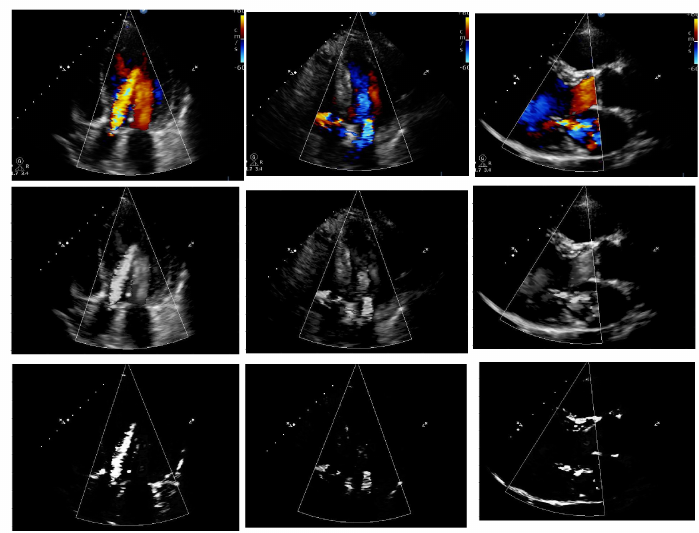
Figure 5. The first row shows the input image, second row the preprocessed images and third row the segmented images for AR, MR and TR respectively.